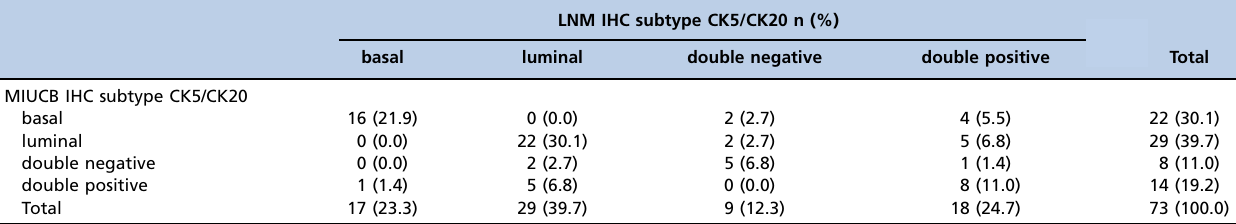
Table 4 - Comparison of the IHC subtypes obtained in the MIUCB and in the respective LNM using CK5 and